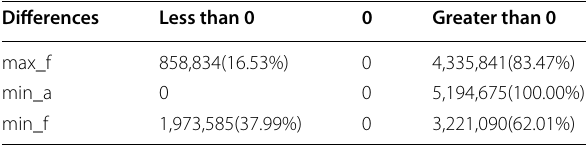
Table 4 Number and percentage of Census Blocks with differences in the population computed from 2SVCA and E2SVCA